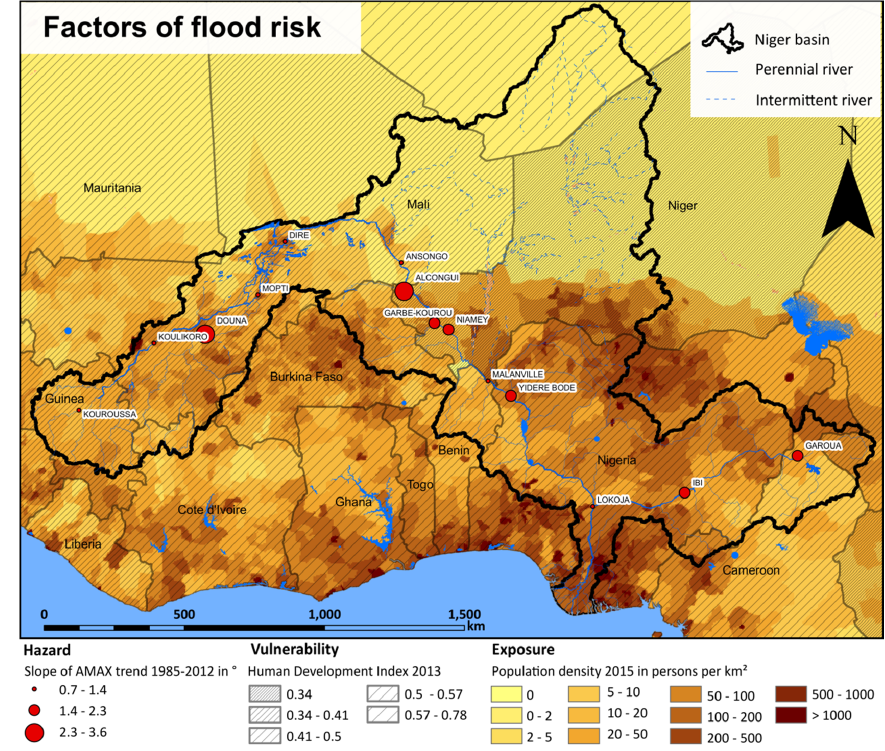
Figure 3. Three factors of flood risk in the Niger River Basin: hazard as annual maximum discharge trend for gauging stations 1985–2012; population density of 2015 as proxy for exposure [38], and the Human Development Index 2013 [40] as proxy for the general vulnerability distribution.